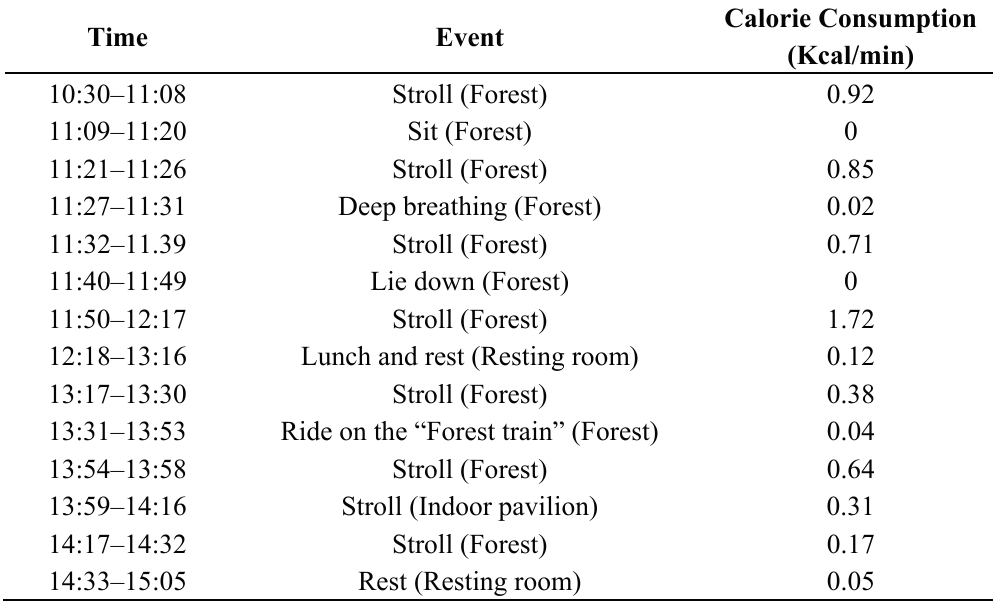
Table 1. Time schedules of and calorie consumption during various activities of forest